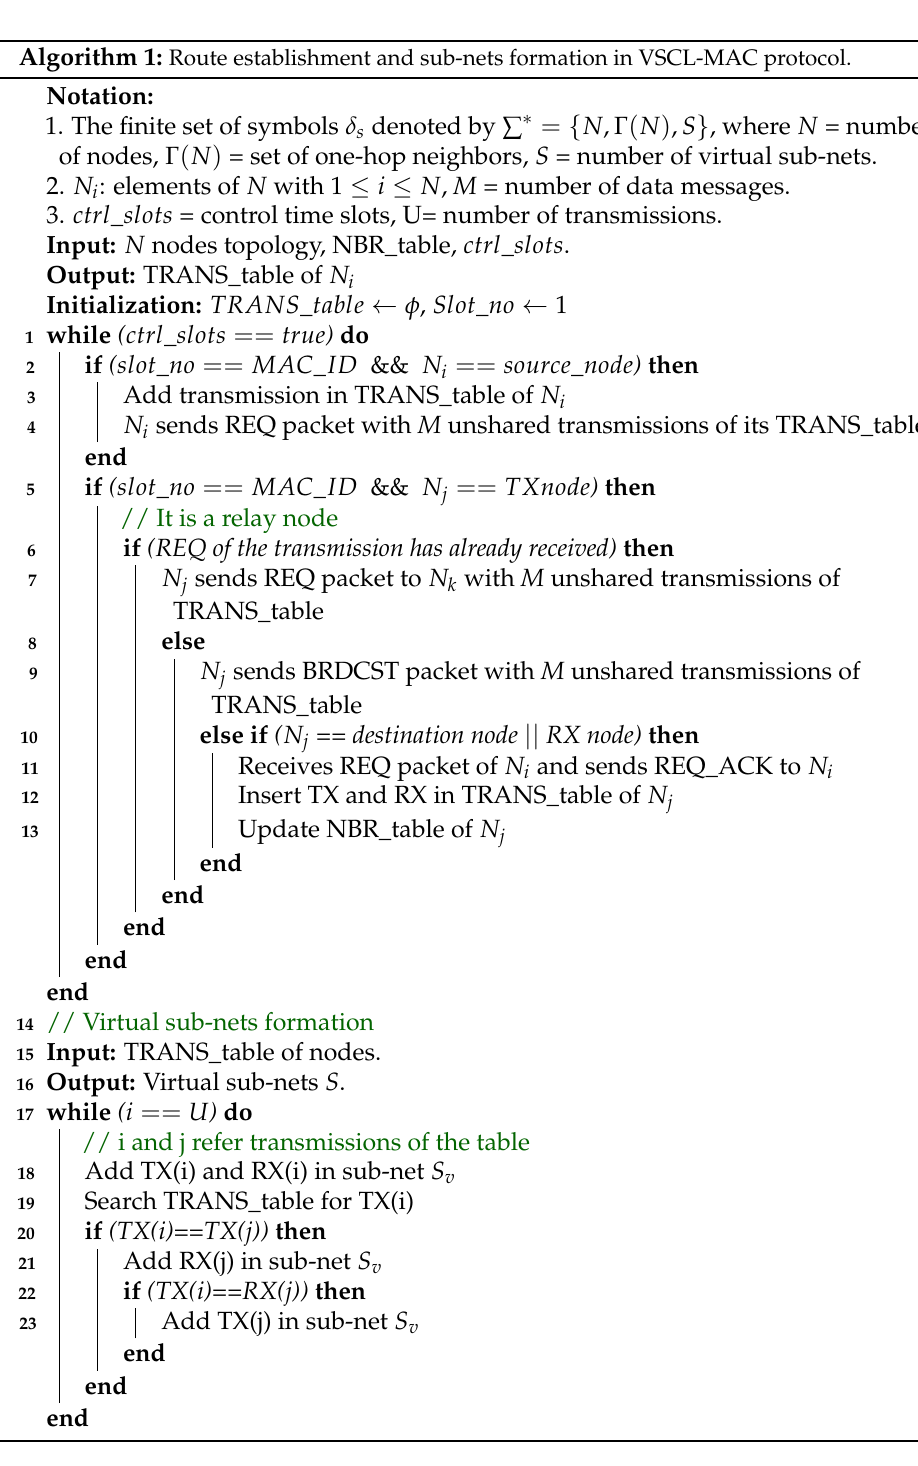
Algorithm 1: Route establishment and sub-nets formation in VSCL-MAC